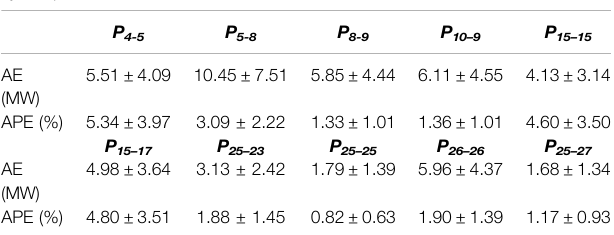
TABLE4| TheAEandAPEstatisticsofthegeneratedreactivedata(IEEE118-bus